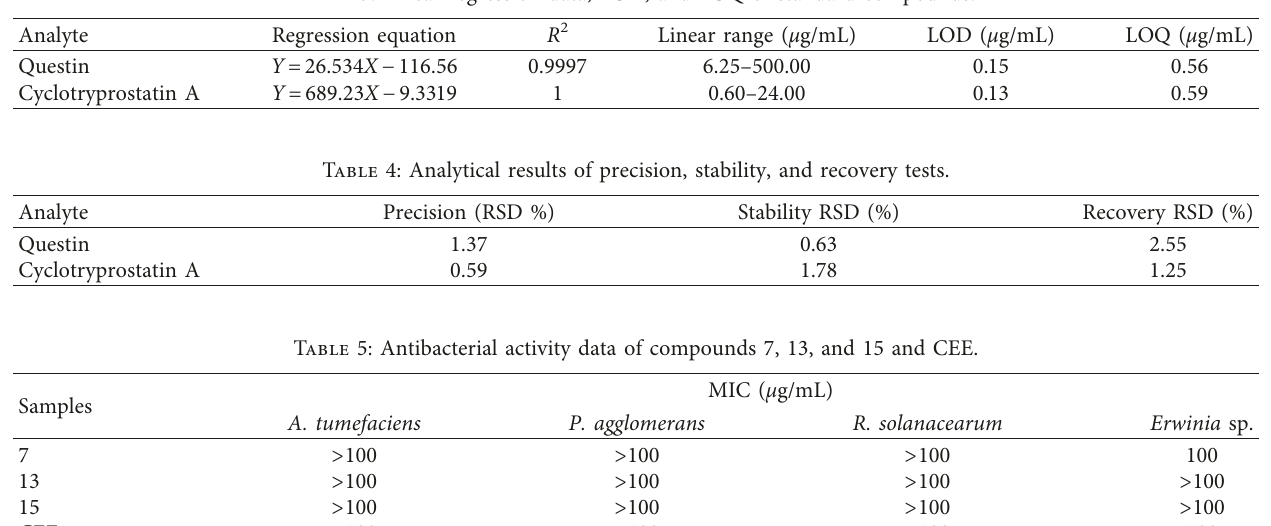
Figure 5: Proposed fragmentation pathways of [M-H] − ions for compound 7 observed in CEE. Table 3: Linear regression data, LOD, and LOQ of standard compounds.